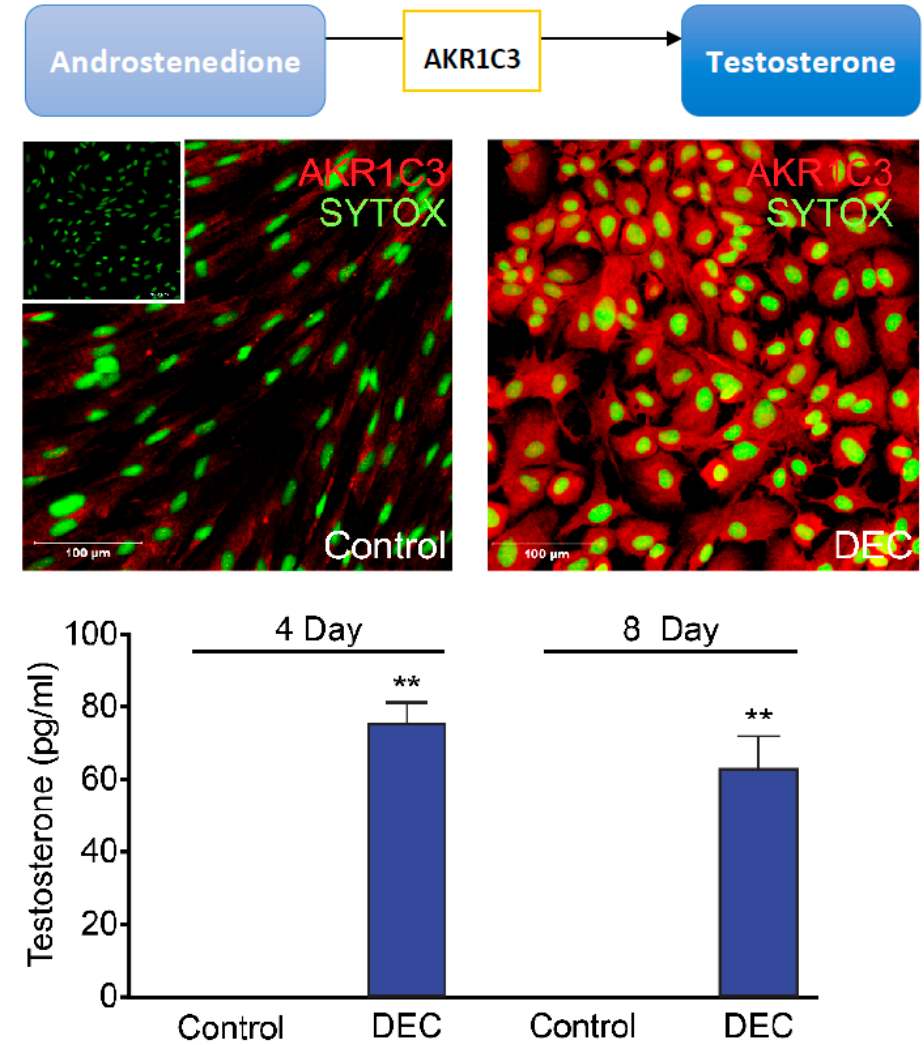
Figure 2. Expression of AKR1C3 in human endometrial stromal fibroblasts is increased in response to a decidualisation stimulus resulting in increased biosynthesis and secretion of testosterone. Based on